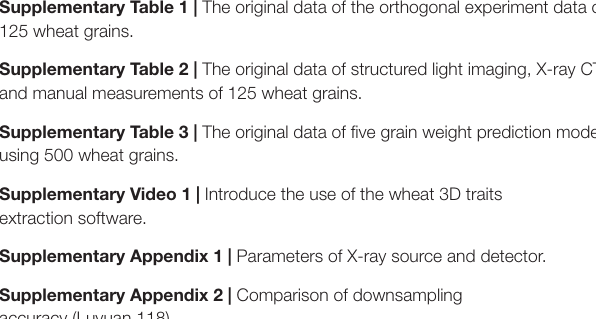
Supplementary Table 1 | The original data of the orthogonal experiment data of 125 wheat grains.